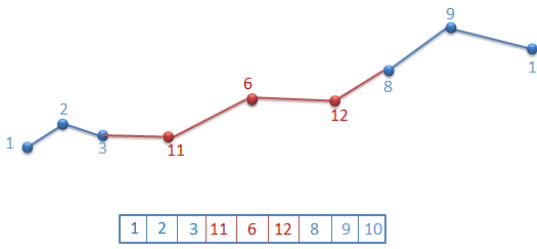
Figure 5. An instance neighbourhood route for the route illustrated in Figure 4.